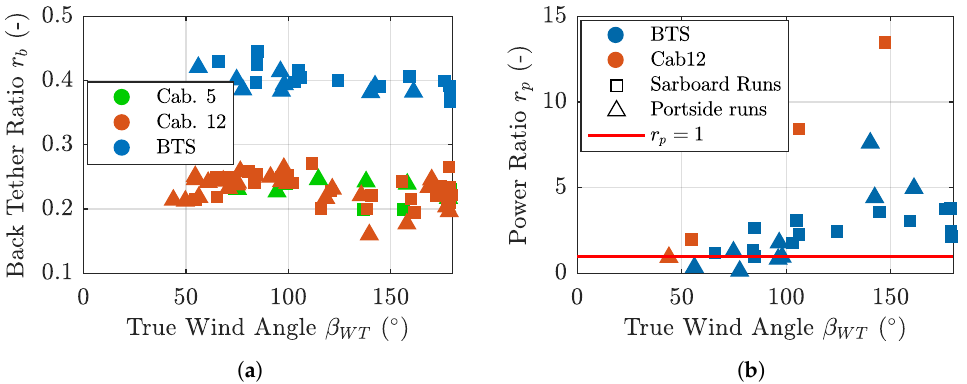
Figure 17. ( a ) Back tether ratio for the three kites. ( b ) Power ratio according to the true wind angle, for two different